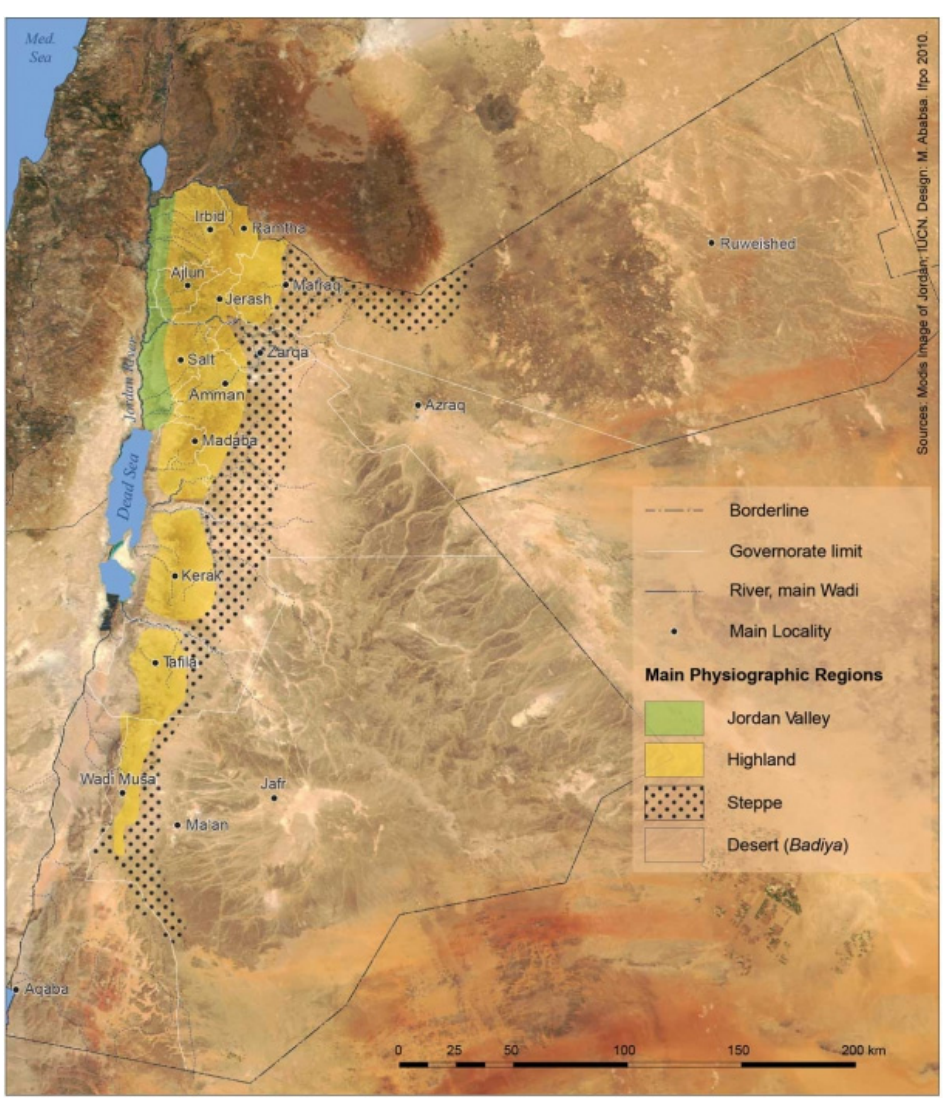
Figure 4. Jordan Four Main Physiographic Region [1].